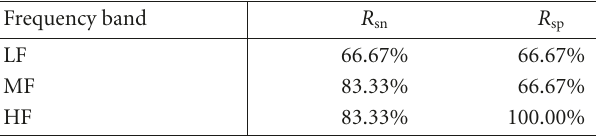
Table 3: Results for the